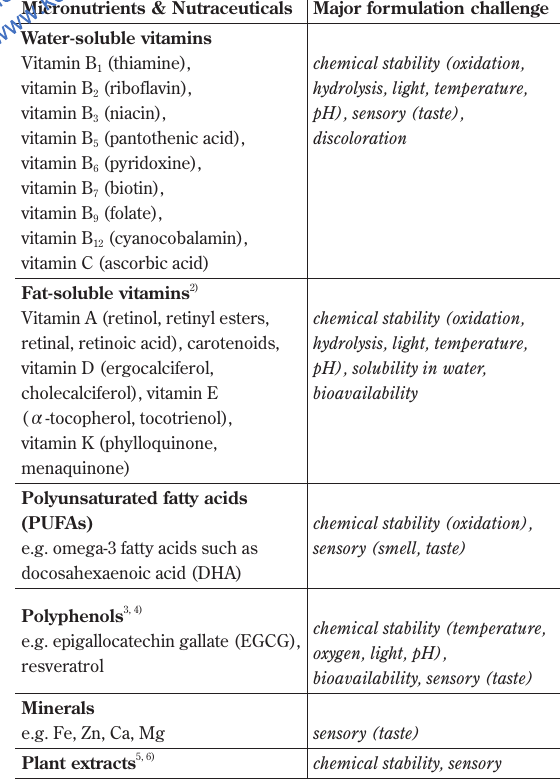
chemical stability (oxidation, hydrolysis, light,